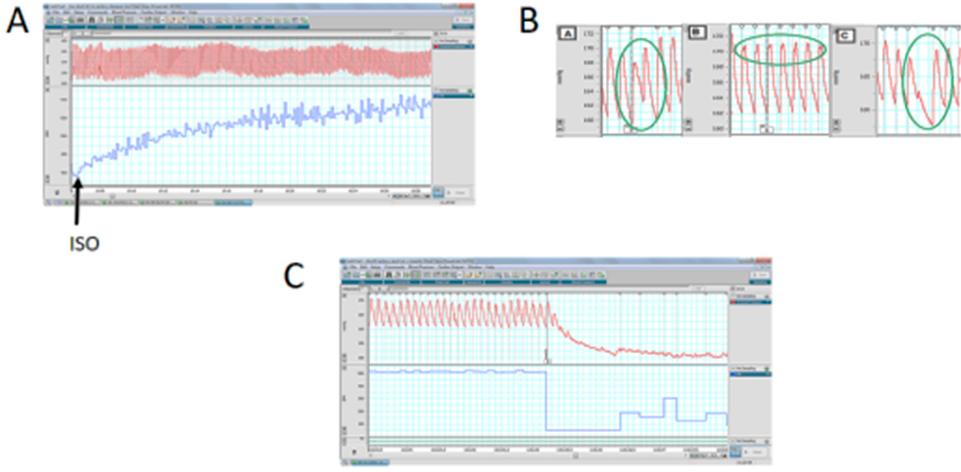
Figure 7. The effect of isoproterenol on the in vivo response in systolic and diastolic pressure (upper part of the graph) and frequency (lower part of the graph). ( A ): The rapid increase in the frequency after administering isoproterenol, without modification of the systolic/diastolic pressure. ( B , C ): The response to isoproterenol in one stressed rat, to demonstrate the presence of extrasystoles (highlighted in the green circle in ( B )) and finally in the failure to recover the heart function in the stressed rats (letter C).